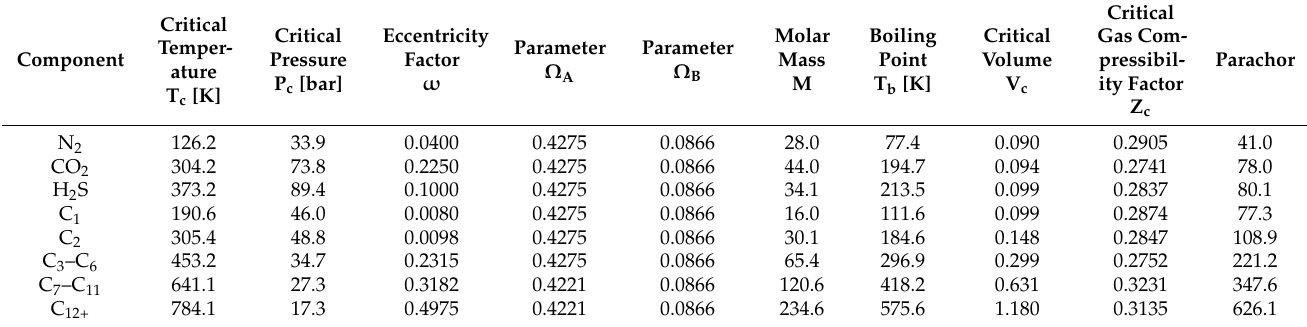
Table 4. Equation of state (EoS) parameters of the reservoir fluid model for the Soave–Redlich–Kwong (SRK) model.